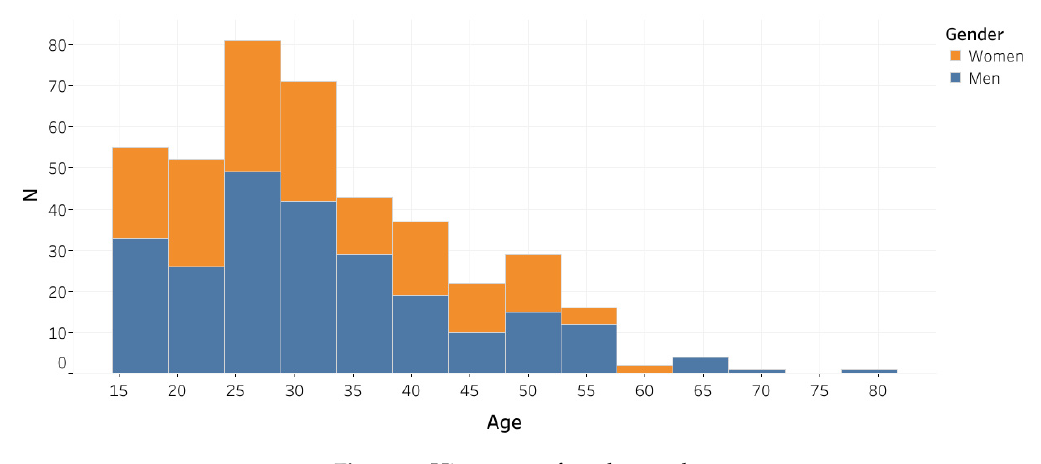
Figure 2. Histogram of age by gender. Table 1. Mean age by gender.